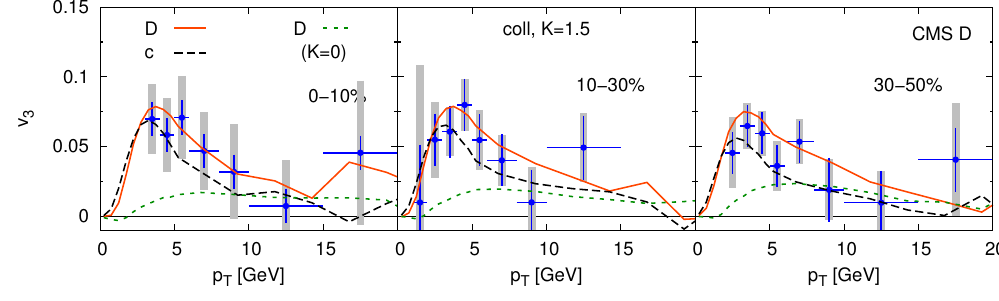
Figure 2. Same as Fig. 1 but for the triangular